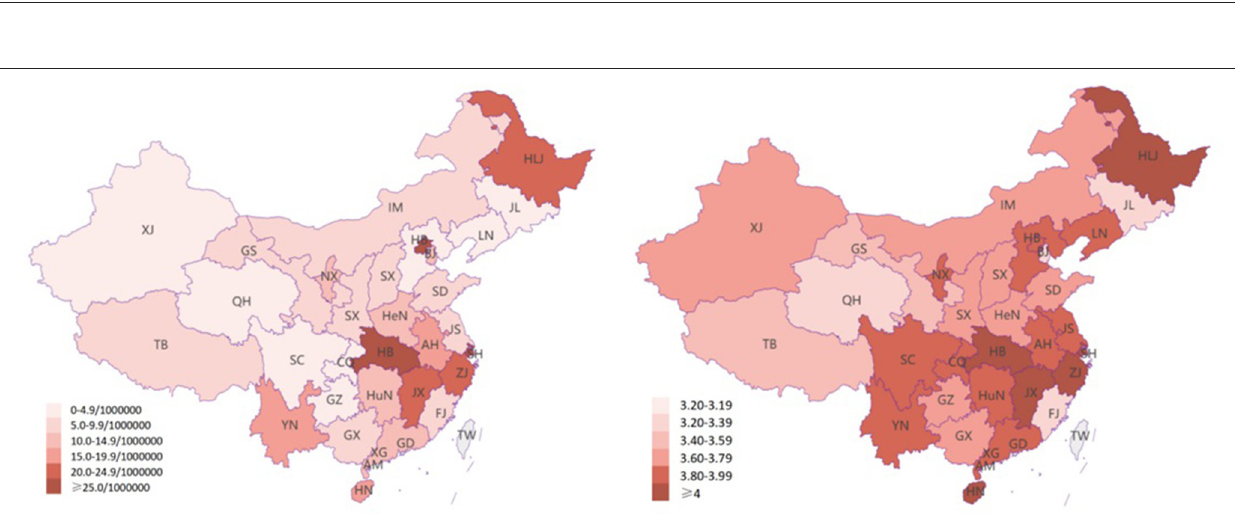
FIGURE 2 | The COVID-19 infection rate and psychological impact in each province and city. The first map shows the provincial proportions of confirmed COVID-19 cases, and the second map shows the psychological